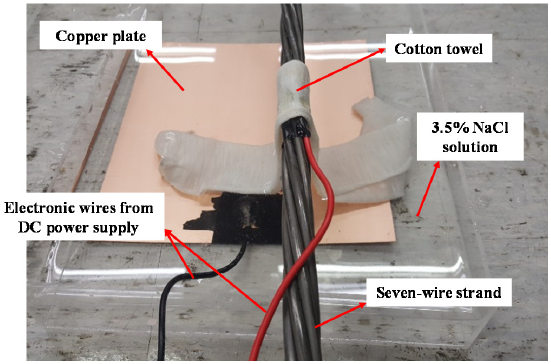
Table 1. Beam test specimens. Figure 2. Induction of electrochemical corrosion using the impressed current method (ICM).